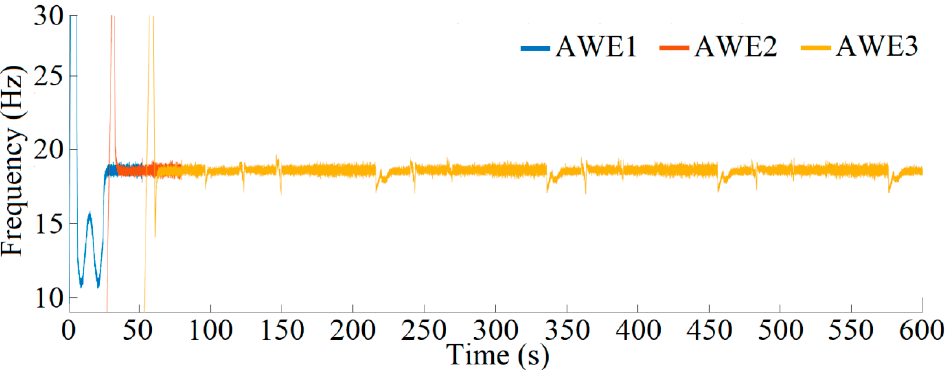
Figure 6. Frequencies of generators.